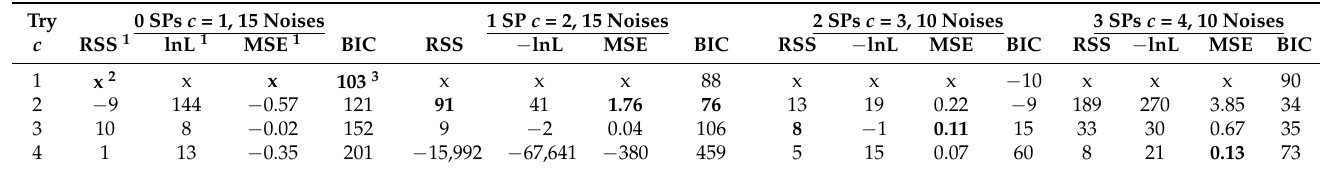
Figure 14. Models employed to determine the number of subdivisions through the suggested indices. Table 4. Determination of the number of subdivisions of models (a)–(d) in Figure 14.